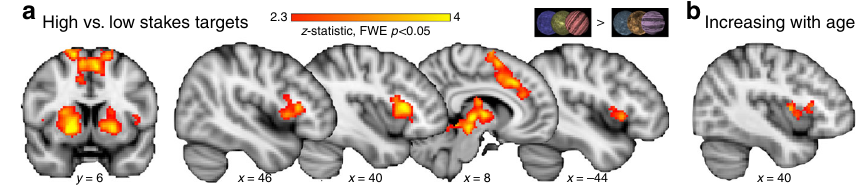
Fig. 3 Stakes-selective functional activity. a High stakes versus low stakes targets activity. Whole-brain corrected statistical map illustrating regions exhibiting enhanced functional recruitment for high stakes relative to low stakes targets across all participants. Contrast represents whole-brain corrected t test (FWE p < 0.05). b Age covariate map. A covariate for age was added to the high > low targets contrast. Increasing age was associated with increased recruitment of bilateral vlPFC for high relative to low targets (right vlPFC shown, small volume corrected t test FWE p < 0.05)